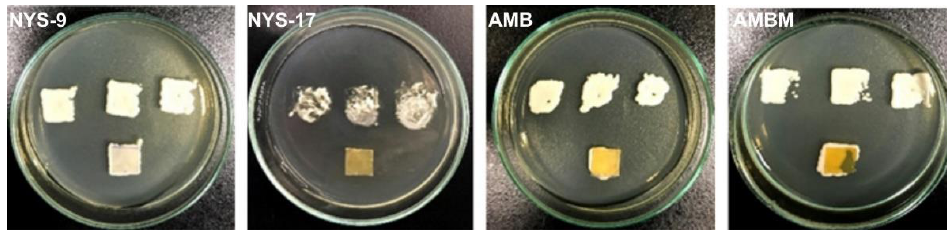
Figure 6. The replication imprints of PHA-polyene films, after 24 h treatment of mature Candida albicans biofilms grown on a micropore filter.